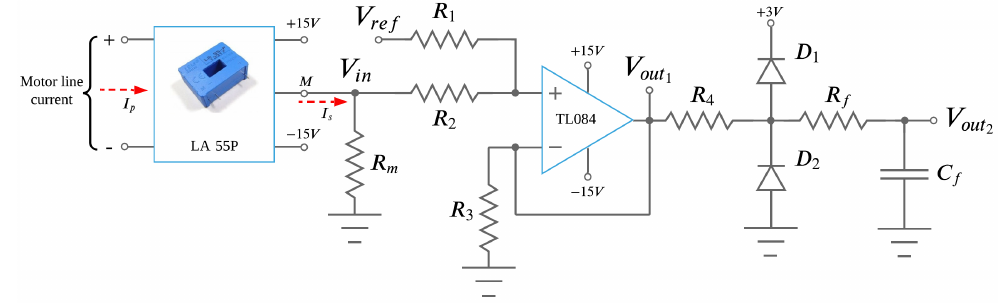
Figure 7. Current signal conditioning